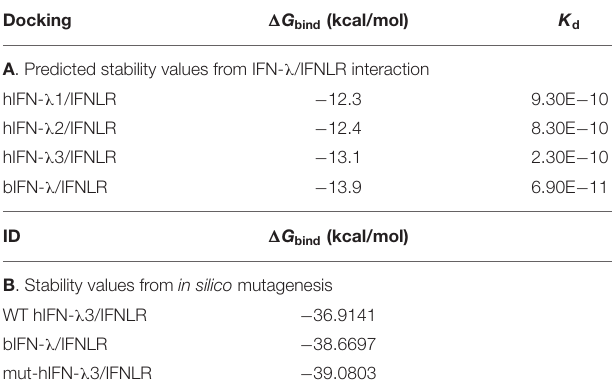
TABLE 2 | Interaction with the human